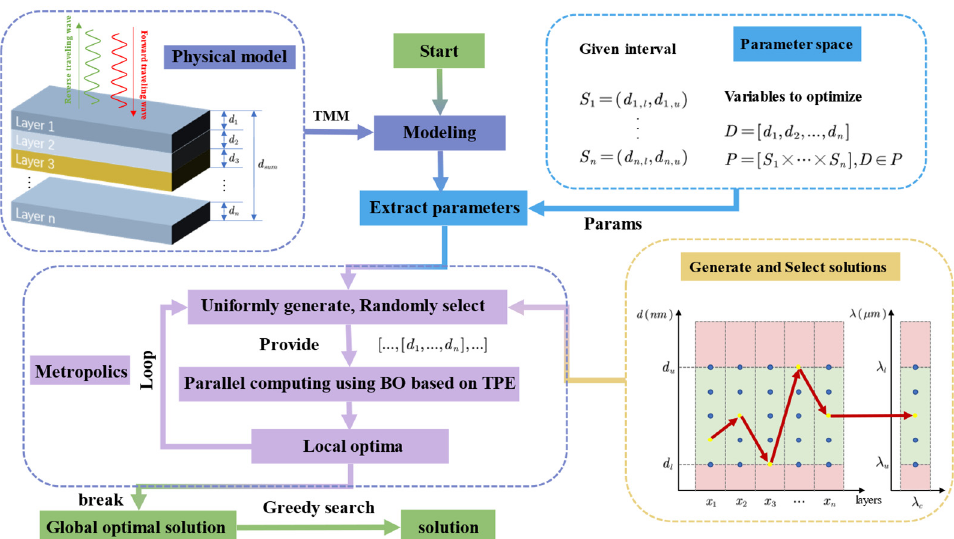
Figure 2. Detailed description of BOnSA flow. In “Generate and Select solutions”, the circles represent solutions generated by means of a uniform distribution. The yellow circles represent the solutions that have been selected, while the blue circles are those that have not been selected during this process. The red arrows demonstrate a visual analogy of parameter selection in the optimization algorithm.